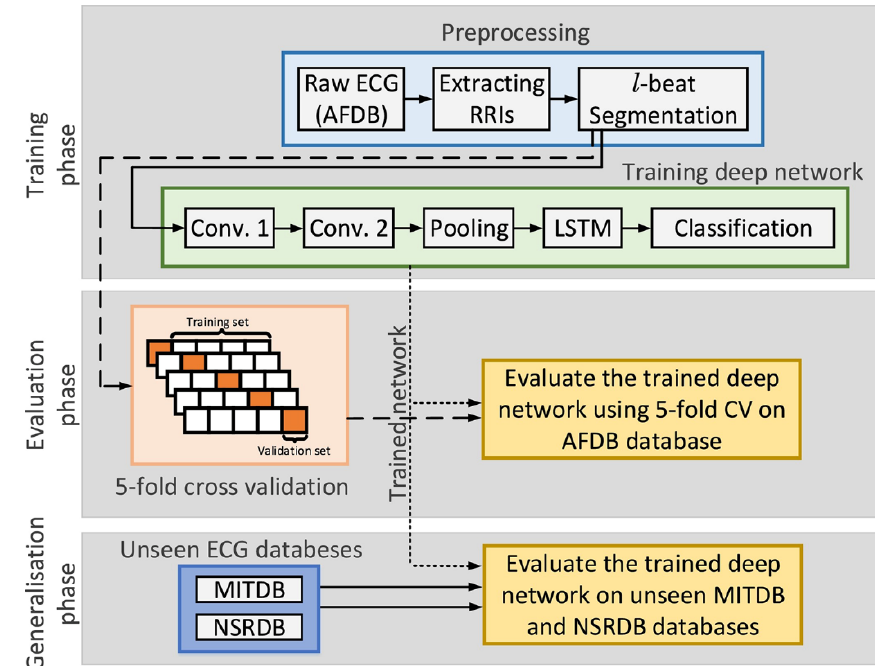
Figure 5. Flowchart of the Convolutional- and Recurrent-Neural Networks (reproduced with Figure5. FlowchartoftheConvolutional-andRecurrent-NeuralNetworks(reproducedwithpermission permission from the authors of [129]). The model consists of a training phase for estimation of the fromtheauthorsof[129]). Themodelconsistsofatrainingphaseforestimationoftheoptimalparameters optimal parameters of model, an evaluation phase for validating performance measures and a of model, an evaluation phase for validating performance measures and a generalization phase to generalization phase to report performance on previously unseen data sets. report performance on previously unseen data